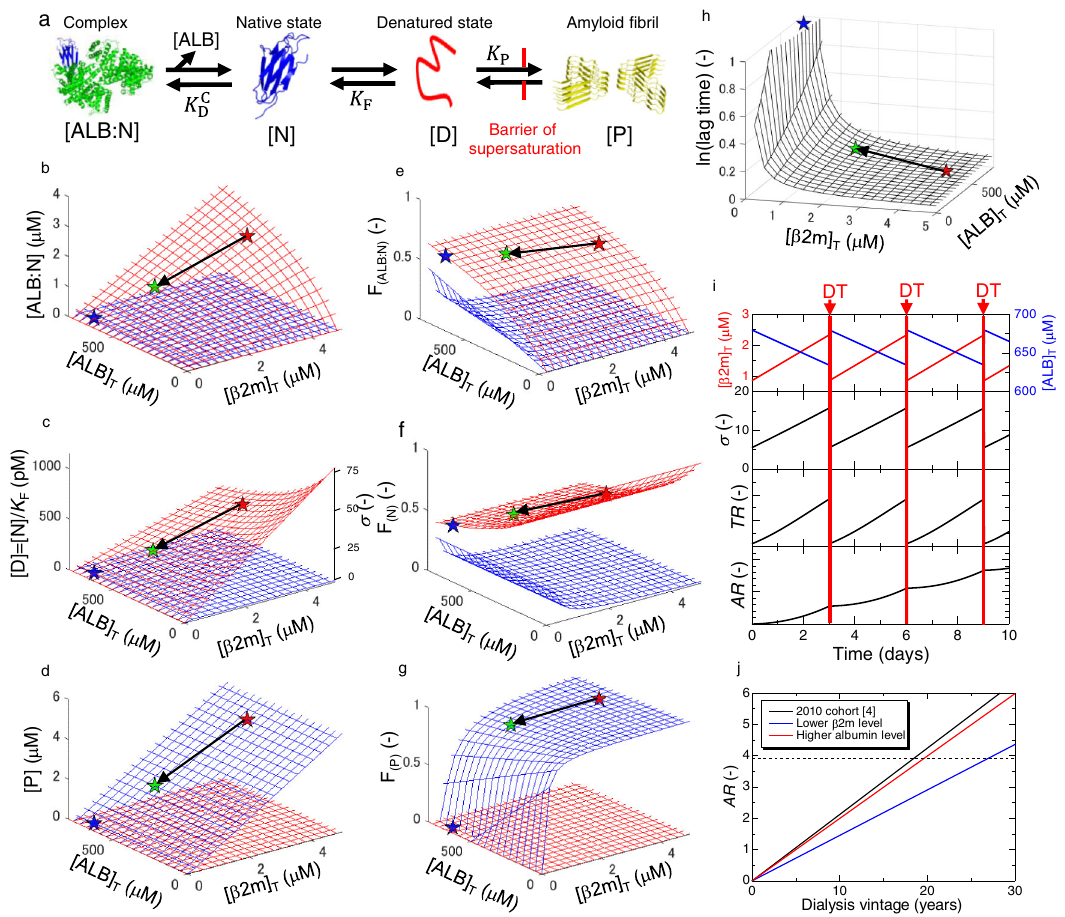
Fig. 6 | The theoretical calculation of β 2m amyloid fi bril formation in a serum milieu. a Schemes of β 2m amyloid fi bril formation in the presence of serum albumin. The molecular illustrations were depicted using PyMOL Molecular Gra- phics (ver. 2.5.1). b – d Dependences on total β 2m ([ β 2m] T ) and serum albumin ([ALB] T ) concentrations of ( b ) native β 2m-serum albumin complex, ( c ) denatured monomer, and ( d ) amyloid fi brils, before (red mesh) and after (blue mesh) break- downofsupersaturation.Inpanel( c) ,theaxisofthesupersaturationratio, σ =[D] S / [D] C , is also shown. e – g Dependences asshown in panels ( b – d ) are represented by fractions of ( e ) native β 2m-serum albumin complex, ( f ) native monomer, and ( g ) amyloid fi brils. h The relative change in the lag time as a function of [ β 2m] T and